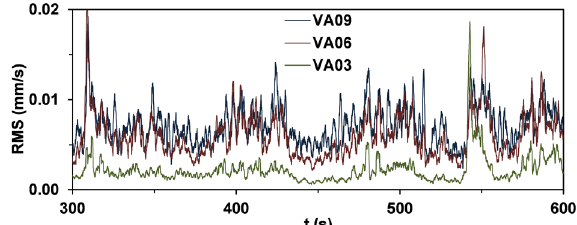
Figure 20. RMSs at Valadier’s buttress in radial direction.